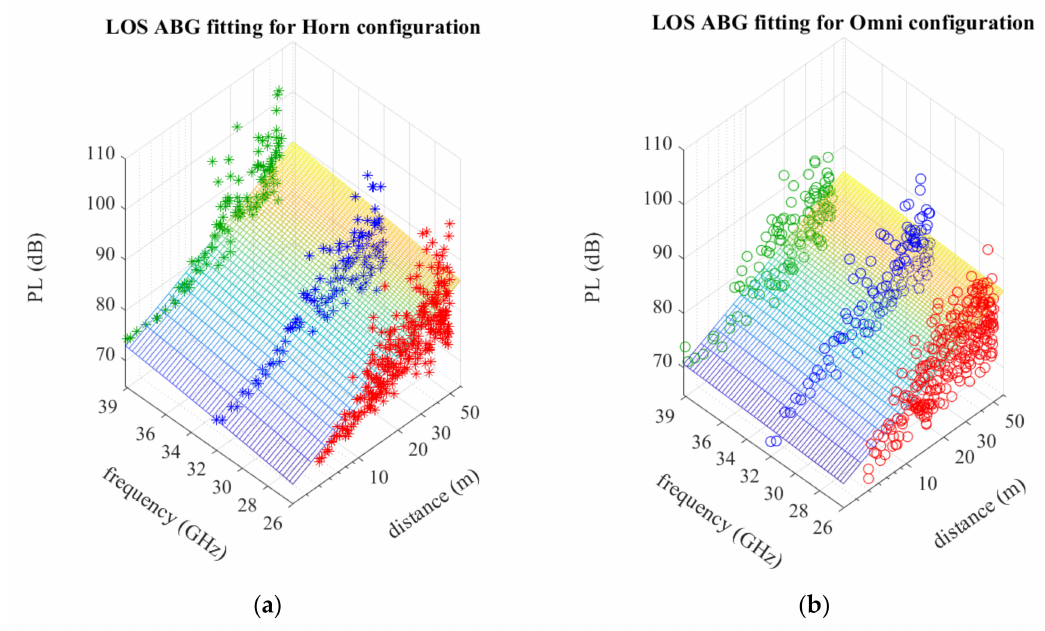
Figure 5. Alpha–beta–gamma ABG fitting for ( a ) Horn (asterisk) and ( b ) Omni (circle) configurations at 26 (red), 32 (blue) and 39 GHz